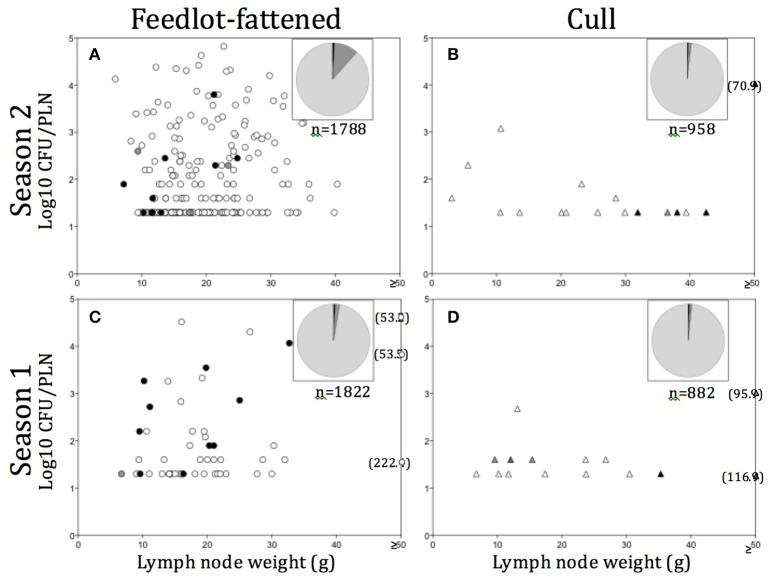
(A–D) Distribution of Salmonella contaminated peripheral lymph nodes (PLN) plotted as Salmonella contamination level (log10 CFU/PLN) vs. PLN weight in grams (g), by season and production source. Numbers in parentheses indicate PLN weight (g) for those found ≥50 g. Pie charts in each (A–D) represent the total number of PLN tested in each season/production source, with light gray representing the proportion tested but negative, medium gray the proportion found positive but not enumerable for Salmonella, and dark gray, the proportion enumerable (>1.6 log10 CFU/PLN). Filled in symbols (O, Δ) indicate particular serotypes observed and include: black, S. Dublin; medium gray, S. Newport; light gray, S. Typhimurium; empty, other serotypes.